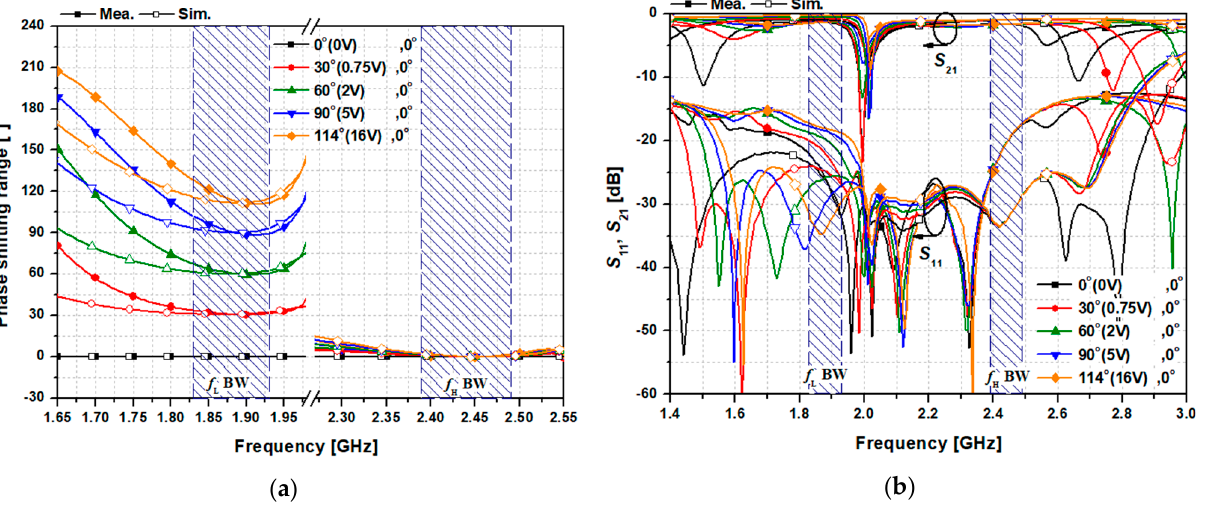
Figure 9. Simulated and measured results of a dual-band PS achieved by varying the bias voltage of the low − band while fixing the bias voltage of the high-band at 0 V: ( a ) PSRs; ( b ) ILs and input/output RLs.